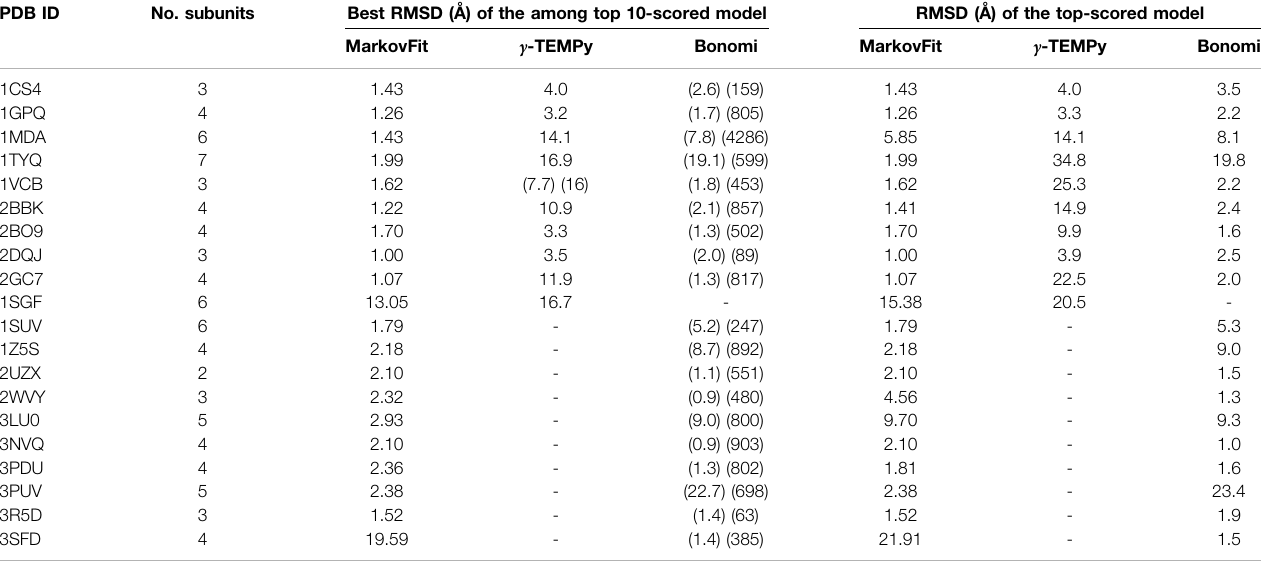
TABLE 4 | Comparison with the two existing methods on simulated maps at 10 Å resolution. PDB ID No. subunits